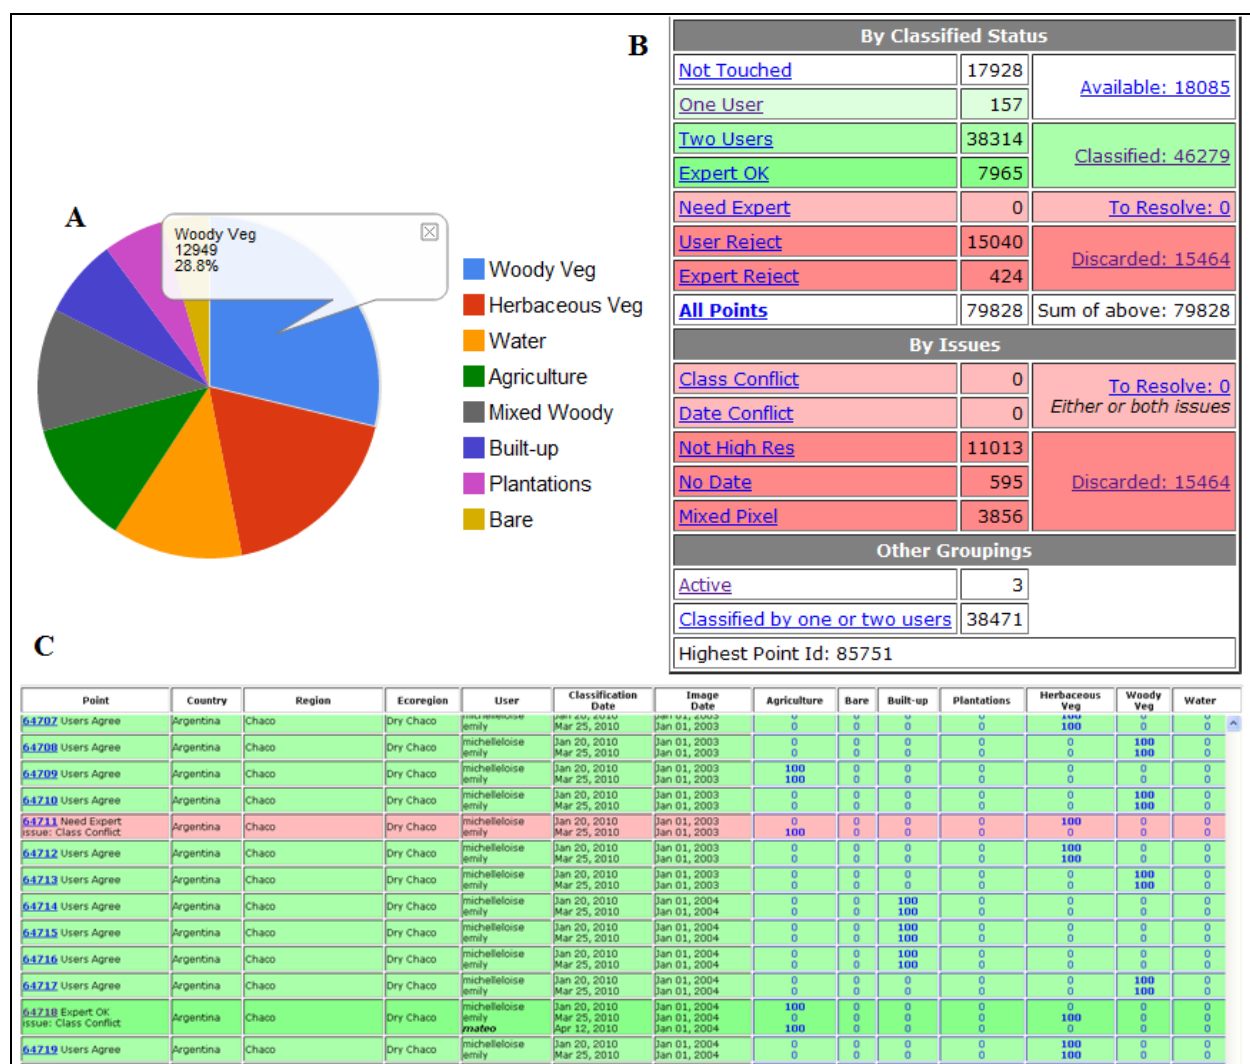
Figure 3. (A) Example pie graph from the Charts page using all available VIEW-IT samples. (B) Tabular view of samples available in the Statistics page. (C) Example of detailed attribute data for